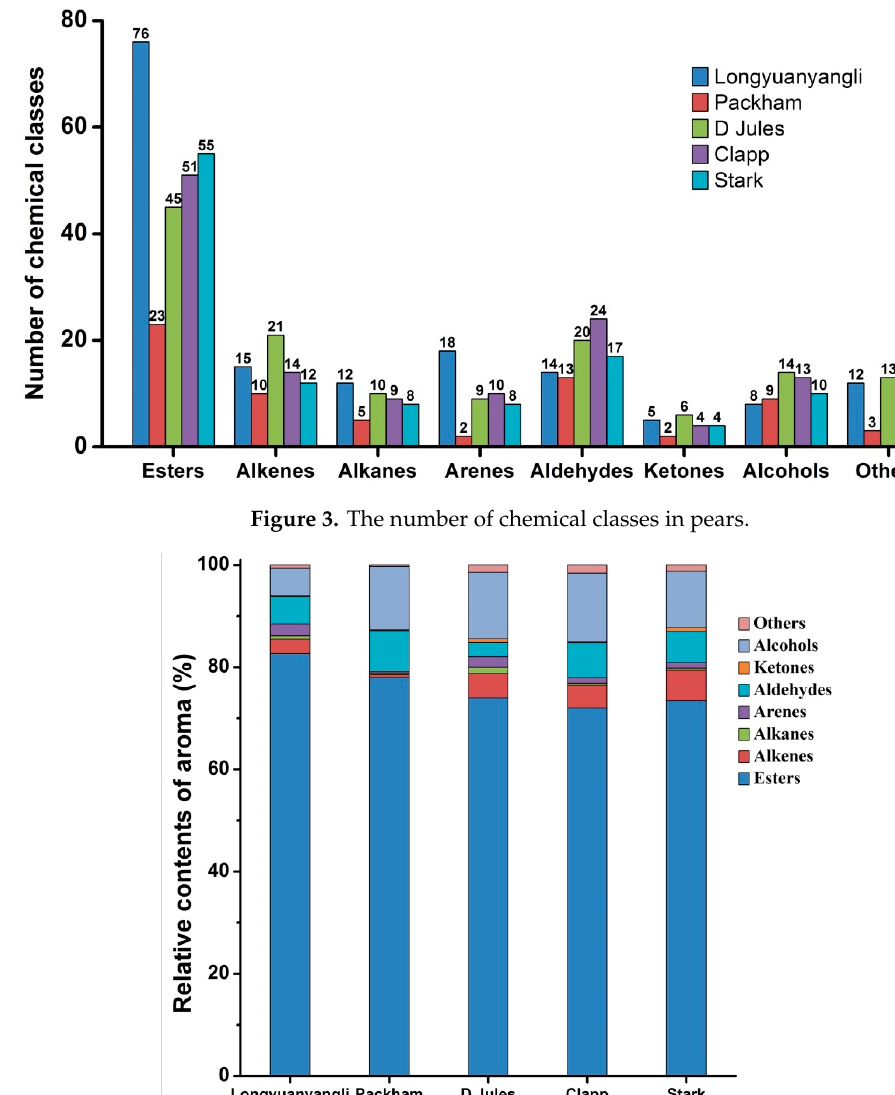
Figure 4. Relative contents of volatile compounds in five pears.